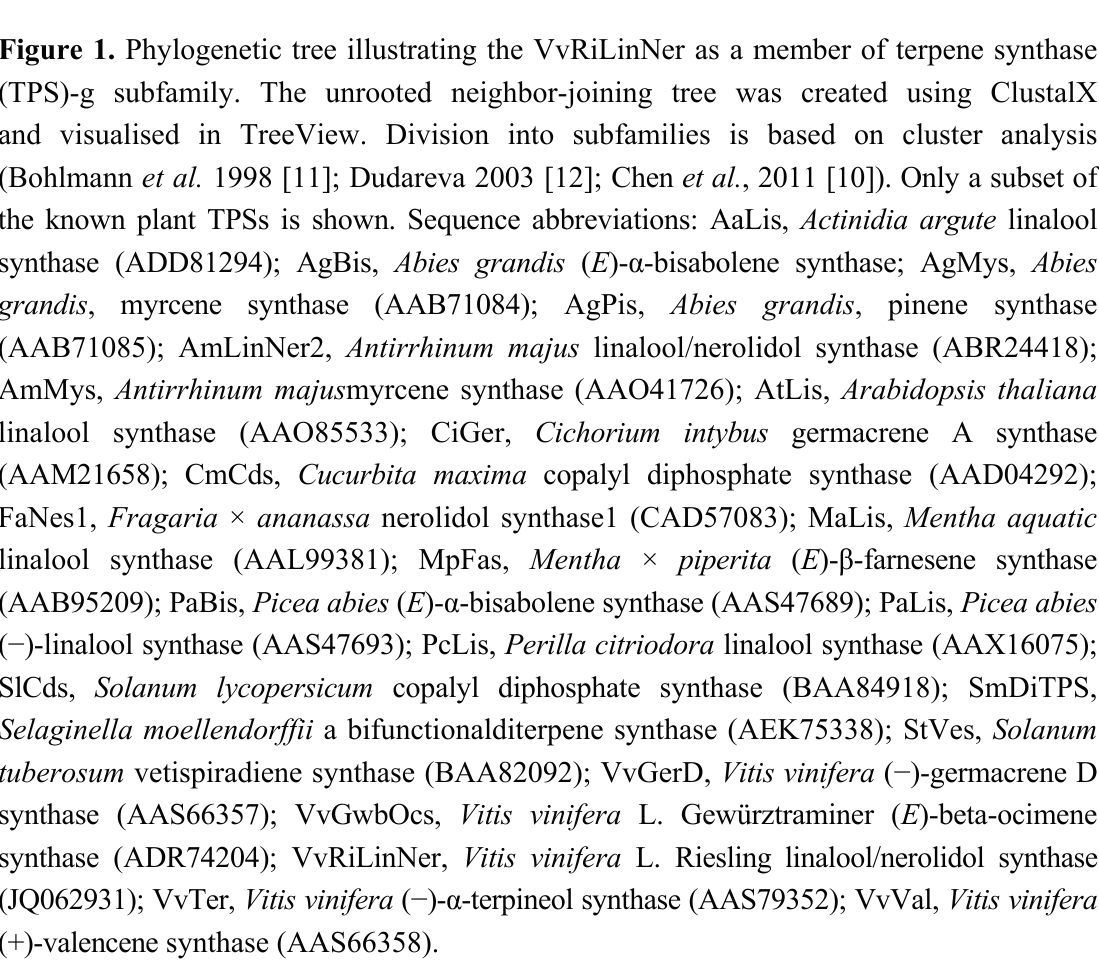
Figure 1. Phylogenetic tree illustrating the VvRiLinNer as a member of terpene synthase (TPS)-g subfamily. The unrooted neighbor-joining tree was created using ClustalX and visualised in TreeView. Division into subfamilies is based on cluster analysis (Bohlmann et al. 1998 [11]; Dudareva 2003 [12]; Chen et al. , 2011 [10]). Only a subset of the known plant TPSs is shown. Sequence abbreviations: AaLis, Actinidia argute